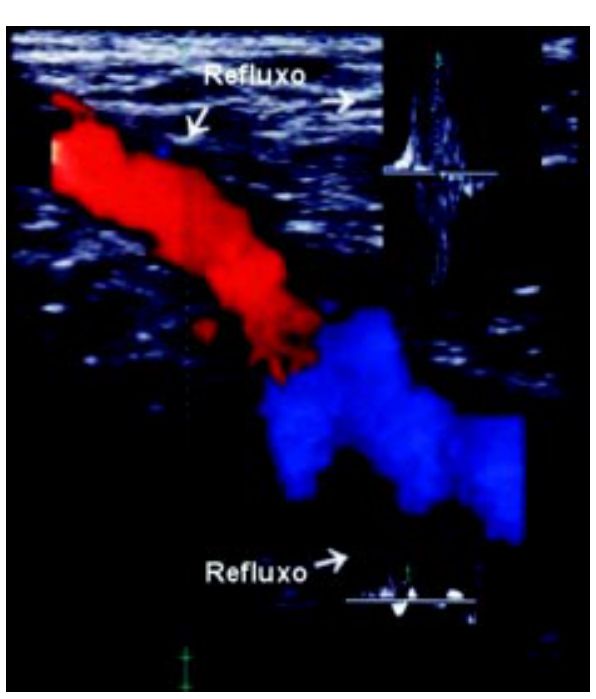
Fig. 5 - Selective reflux in the ostial valve of the great saphenous